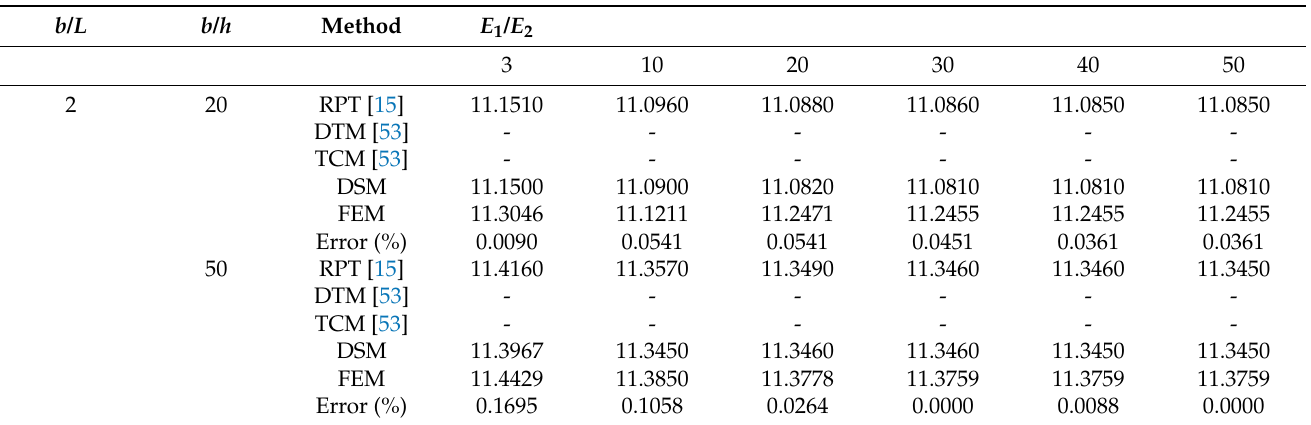
(cid:16) (cid:17) E 1 and the given value of the side-thickness ratio (cid:4673) and the given value of the side-thickness ratio E 2 (cid:3006) (cid:3118)